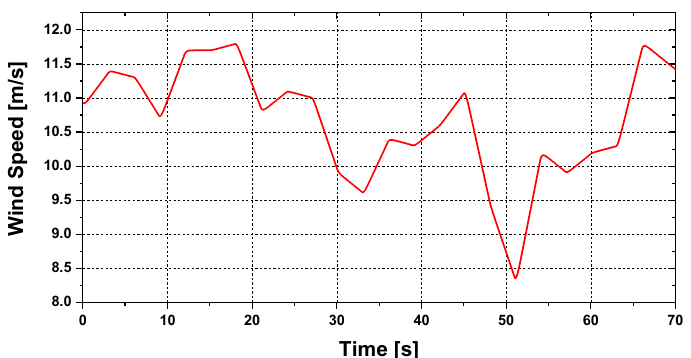
Figure 16. Rotor speed response of SGs.